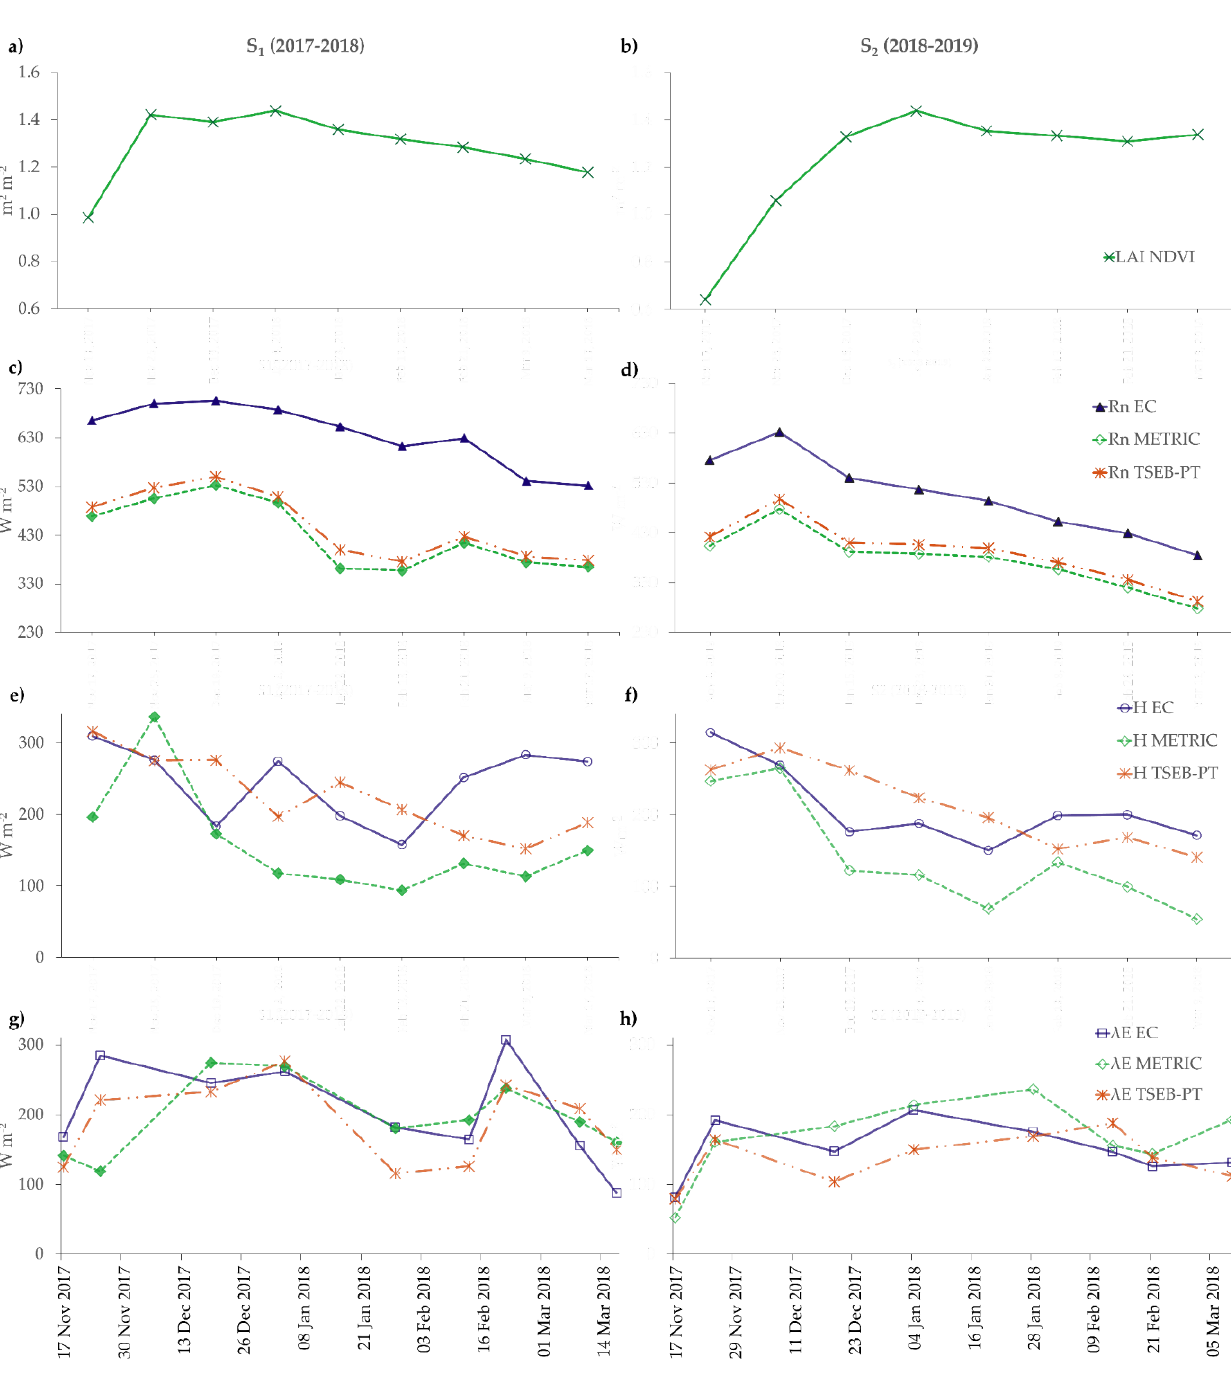
Figure 7. Leaf area index and energy balance components involved in the measured and modeled instantaneous latent heat flux pattern during S 1 (2017–2018) and S 2 (2018–2019) in Landsat 7 and Landsat 8 satellite overpass time. ( a , b ) Leaf area index estimated from Landsat 7–8 ( LAI NDVI ) data in m 2 /m 2 . ( c , d ) Net radiation measured by eddy covariance ( Rn EC) and modeled by METRIC ( Rn METRIC) and TSEB-PT ( Rn TSEB-PT). ( e , f ) Sensible heat flux measured by eddy covariance (H EC) and modeled by METRIC (H METRIC) and TSEB-PT (H TSEB-PT). ( g , h ) Latent heat flux measured by eddy covariance ( λ E EC) and modeled by METRIC ( λ E METRIC) and by TSEB-PT ( λ E TSEB-PT).